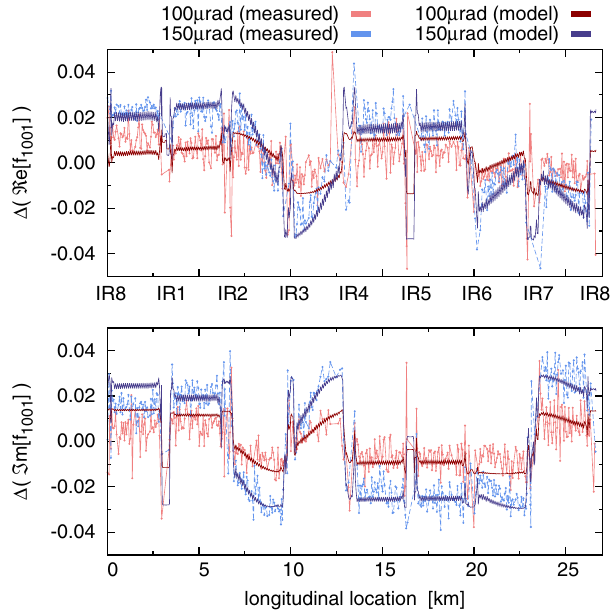
FIG. 17. Measurement of f 1001 at 100 (light red) and 150 μ rad (light blue) crossing angles. The values plotted are the difference of the real (top) and imaginary (bottom) parts of the RDT with respect to measurement at flat orbit, for all BPMs around the ring. Simulated RDT shifts for a model which includes normal sextupole and skew octupole corrector powering which best reproduced the crossing angle scan are shown (dark red/dark